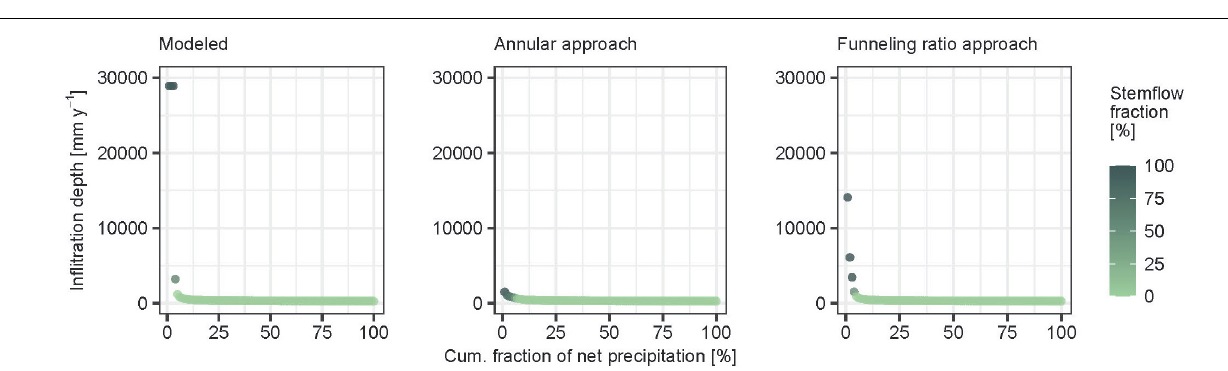
for hydraulic conductivity ( K s ), and 1 m for field